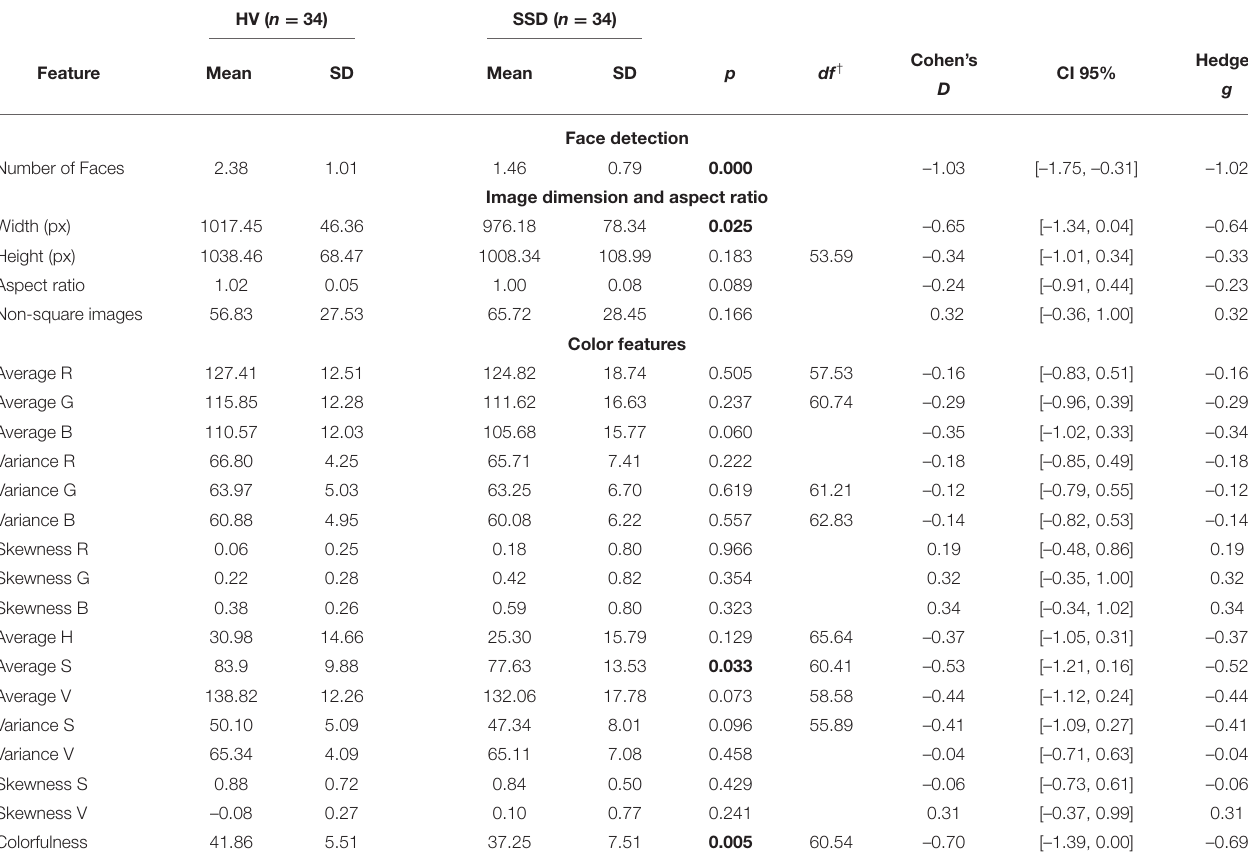
TABLE 3 | Overview of differences in image